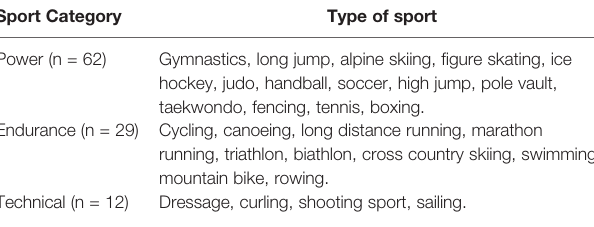
TABLE 1 | Sport category and type of sport for the female Olympic